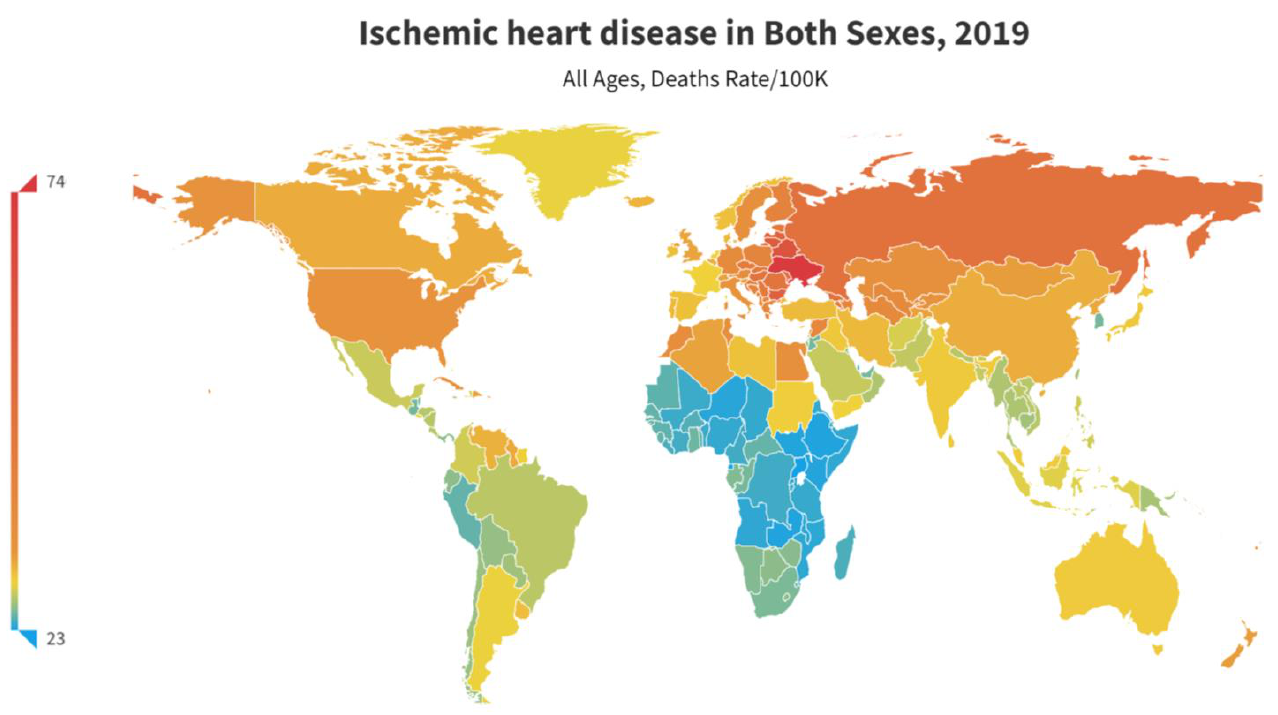
Figure 1. Global death rate due to ischaemic heart diseases. Source: Institute for Health Metrices Evaluation. Used with permission. All rights reserved.